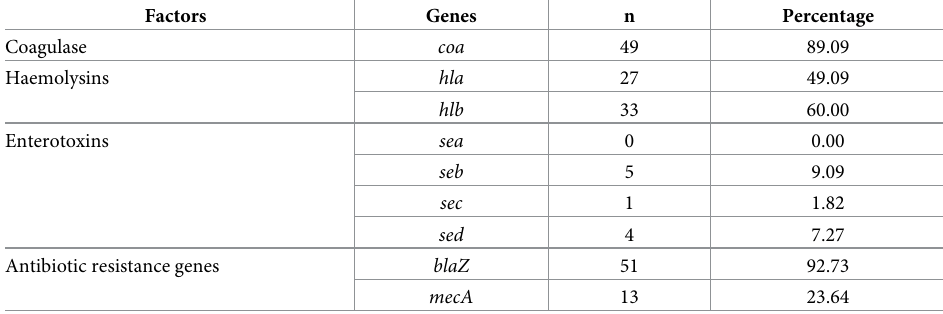
Table 2. Detection of virulence factors and antibiotic resistance genes in S . aureus (n = 55)